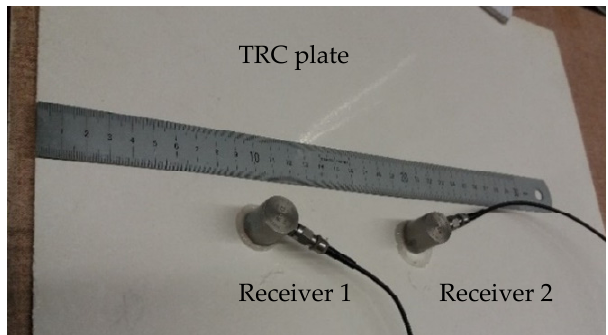
Figure 4. TRC plate with AE sensors at a distance of 100 mm.